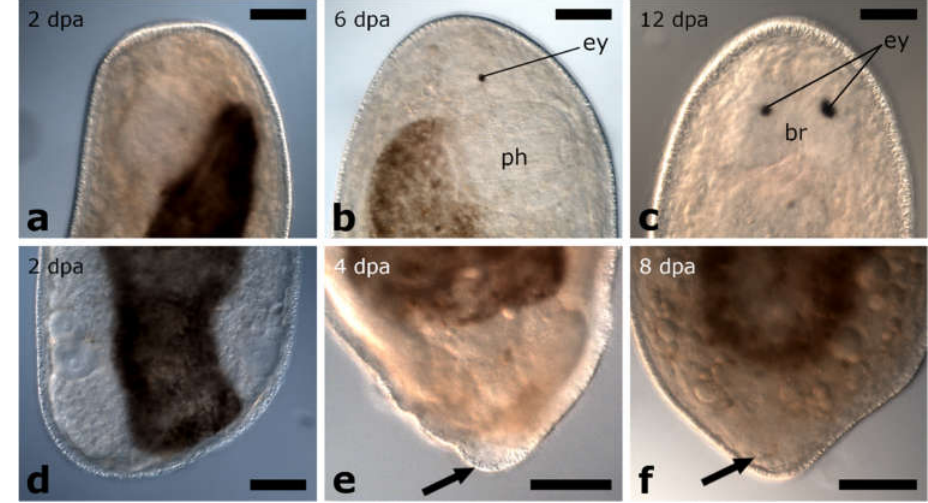
Figure 9. Blastema-like tissue in posterior and anterior regenerates of Plagiostomum girardi . Amputation between brain and pharynx ( a – c ) lead to complete wound healing in anterior regenerates ( a ), followed by the restoration of the original head shape ( b ) and eye regeneration ( c ). After being amputated posterior to the pharynx ( d–e ), first, complete wound healing was observed in posterior regenerates ( d ). Then, a small, blastema-like structure was build ( e ) which grew to a pointy, new tail tip ( f ). Arrows are pointing at the blastema-like tissue. Abbreviations: br, brain; ey, eye; ph, pharynx. Scale bar is 100 µm.